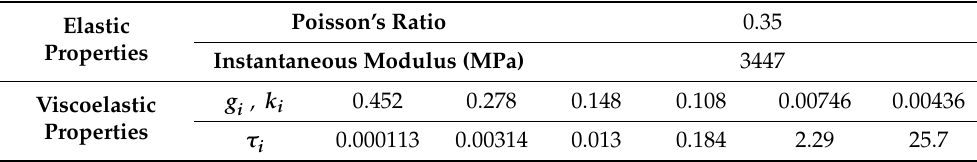
Table 1. HMA Prony series parameters.